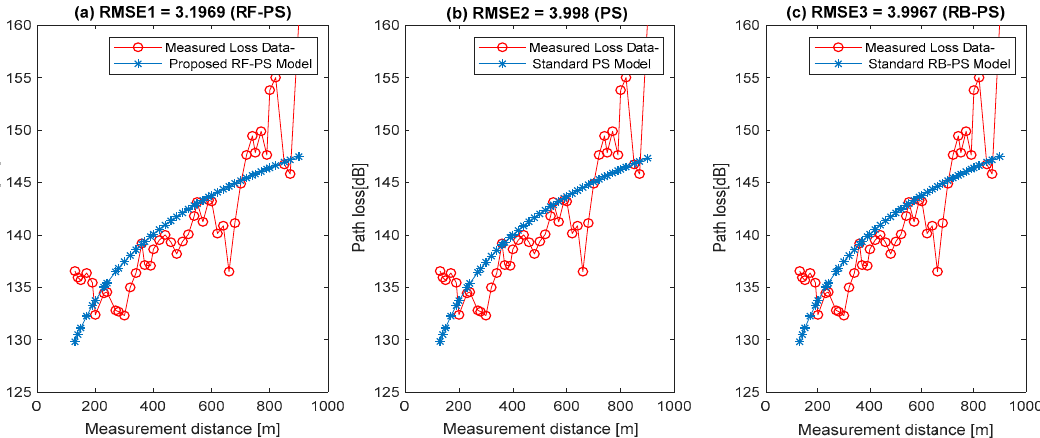
Figure 13. Results showing the measured path loss versus distance using the hybrid RF-PS method and two existing standard path loss prediction methods in site 3 of location 2.